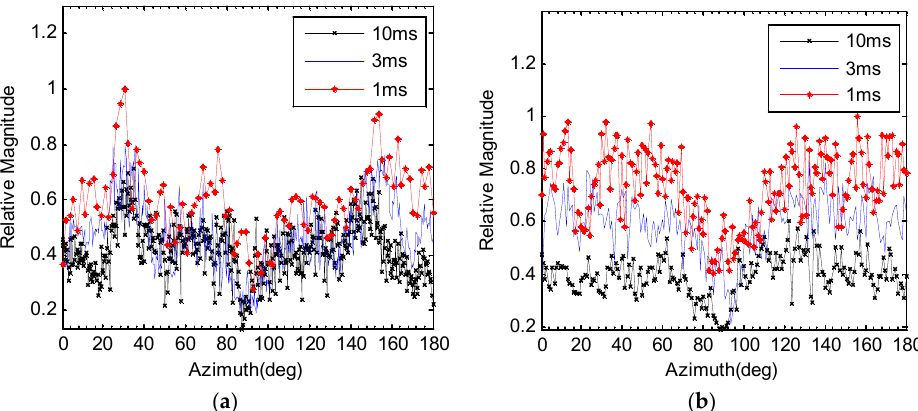
Figure 10. ( a ) Fluctuation intensity of the CW echo envelope with different pulse lengths; ( b ) fluctuation intensity of the wideband echo envelope with different pulse lengths.